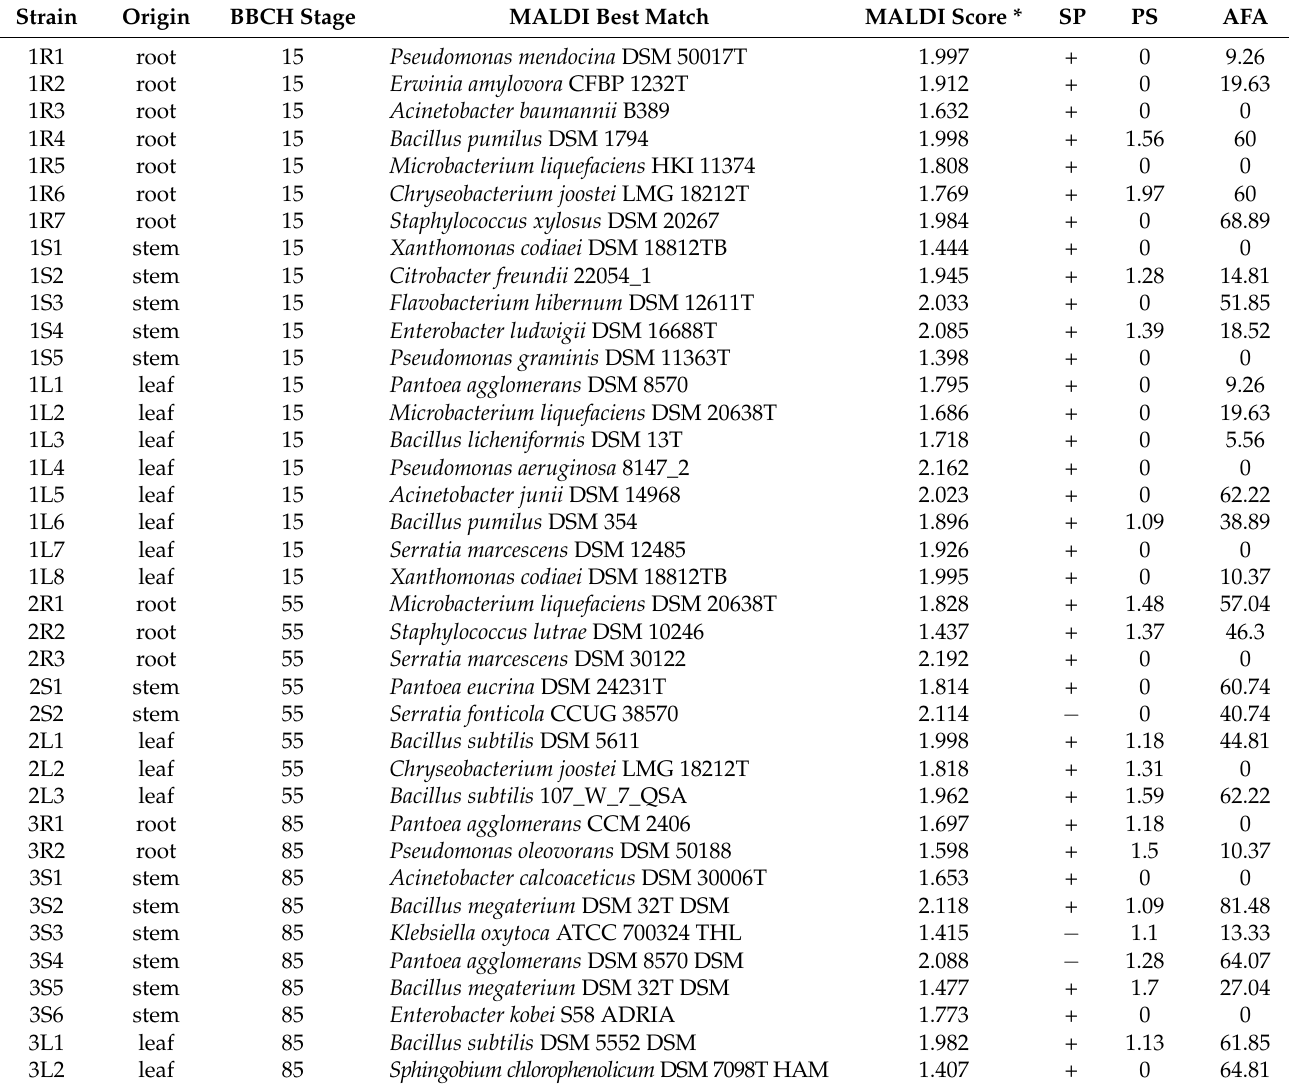
Table 1. Bacterial isolates obtained from surface sterilized plants of rapeseed ( Brassica napus ). Origin, identification according to MALDI TOF, siderophore production (SP), phosphate solubilization (PS), and antifungal activity (AFA) against Leptosphaeria maculans . Strain